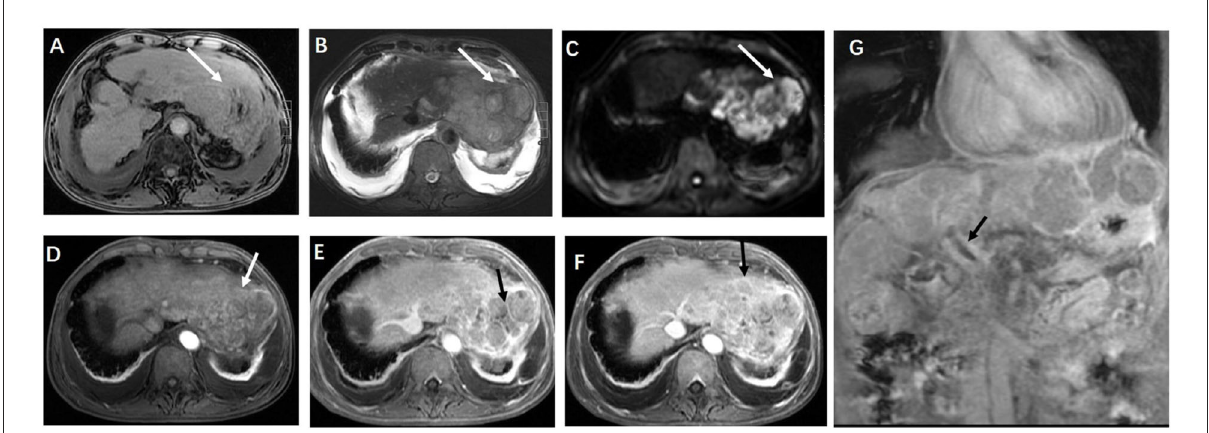
FIGURE2 (A) Axial T1-weighted magnetic resonance imaging (MRI) and (B) axial T2-weighted MRI scans showed a bulky multicystic hepatic mass with multiple septa (arrowheads) situated in the left hepatic external lobe, and (C) a diffusion-weighted MRI scan presented a restriction of diffusion. Axial contrast-enhanced T1-weighted MRI scans showed local enhancement in the lesion, and most of the lesion suggested the absence of being not significantly obviously enhanced in the arterial phase (D) , and mild to moderate delayed enhancement was found in the perifocal and internal septum of the portal venous phase (E) and the delayed phase (F) (arrow) (G) Coronal contrast-enhanced presented with a filling defect in the trunk of the portal vein